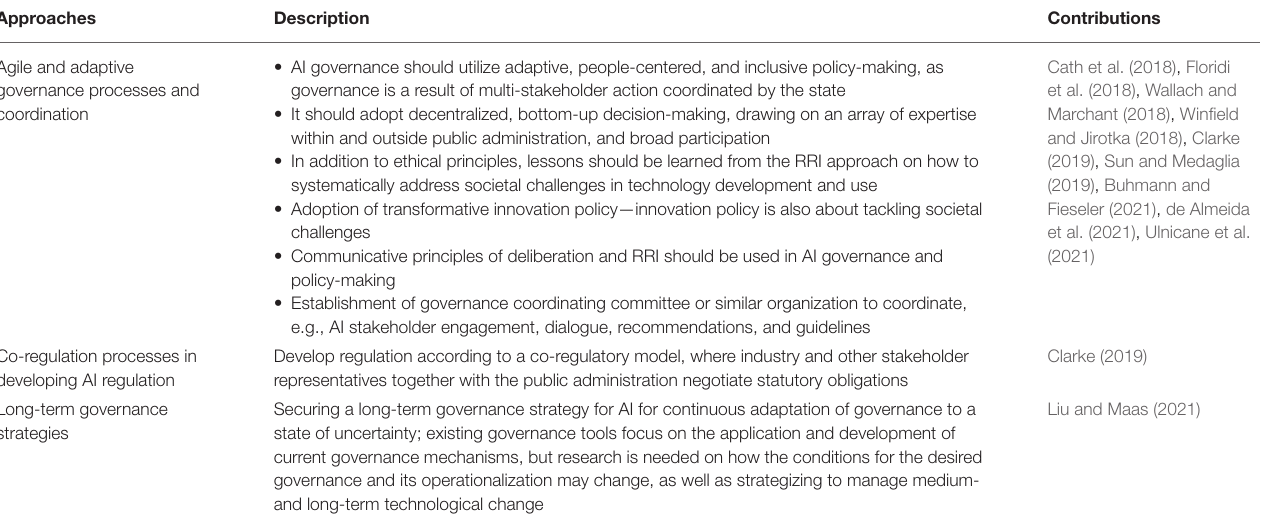
TABLE 3 | Approaches for improving the governance of